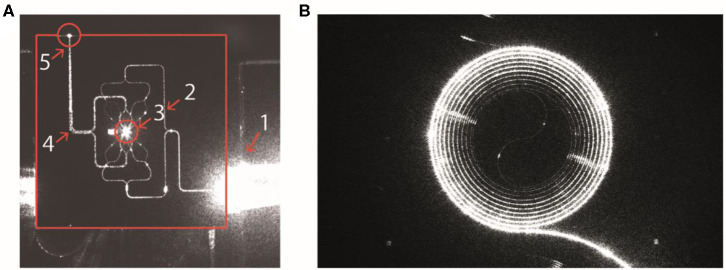
Integrated photonics based lab-on-a-chip Raman spectroscopy. (A) Device type 1: Camera image of a device with 16 waveguides for trapping and four waveguides for detection. The device is actuated with light from an input fiber that is embedded in a fiber array unit (FAU) at the lower right-hand side. The various structures light up as a result of light scattering, causing some saturation of the camera. The solid red lines indicate the chip edges. 1, FAU; 2, excitation-waveguide circuitry; 3, microfluidic bath with the central trapping region; 4, detection-waveguide circuitry; 5, light from the trap that is coupled out by the detection waveguides. Here, the detection waveguides collect light as a result of direct illumination and scattering (from Loozen et al. (53)). (B) Device type 2: Spiral waveguide with the Raman pump light traveling inside the waveguide. The Raman signal is (partially) scattered back into the waveguide and collected at the front entrance. Reproduced with permission from Lee (54).